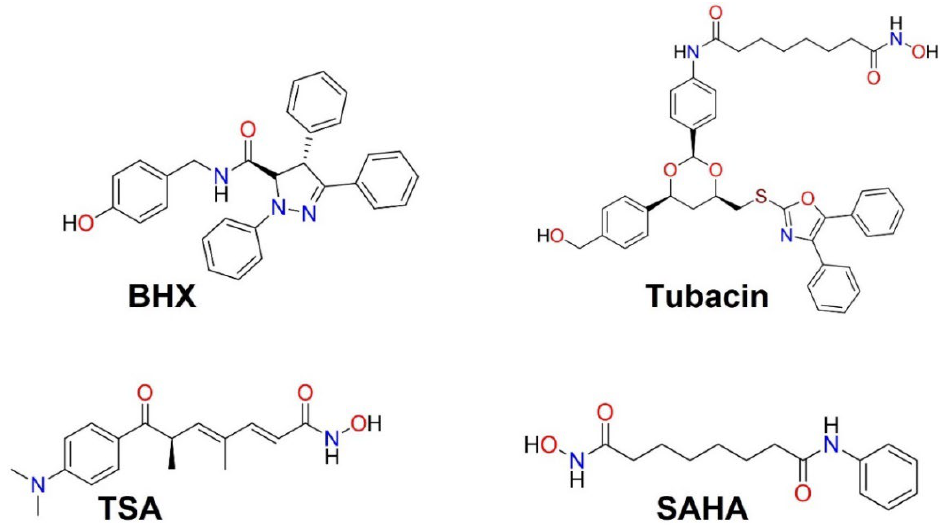
Figure 1. BHX, tubacin, trichostatin A (TSA), and suberoylanilide hydroxamic acid